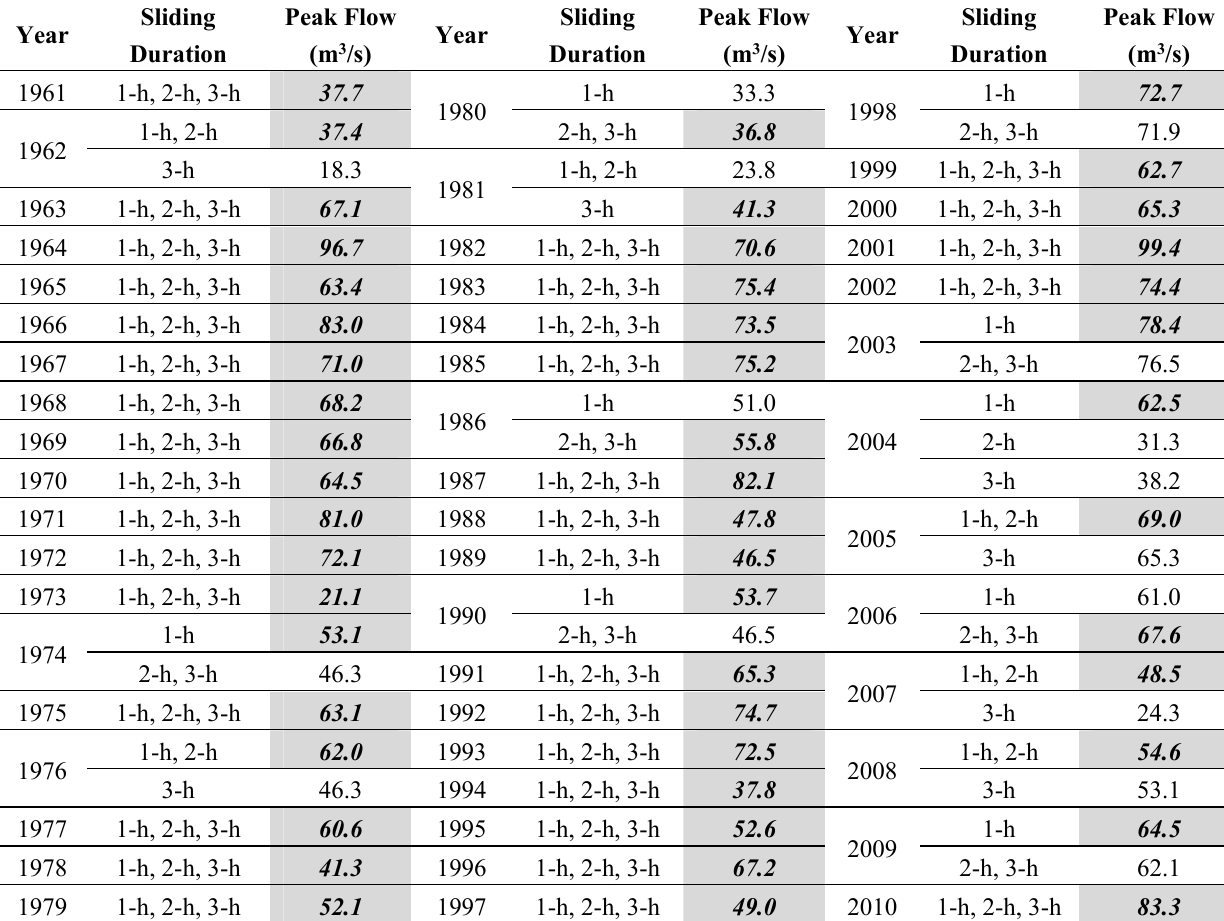
Table 6. The simulated peak flows and maximum annual peak